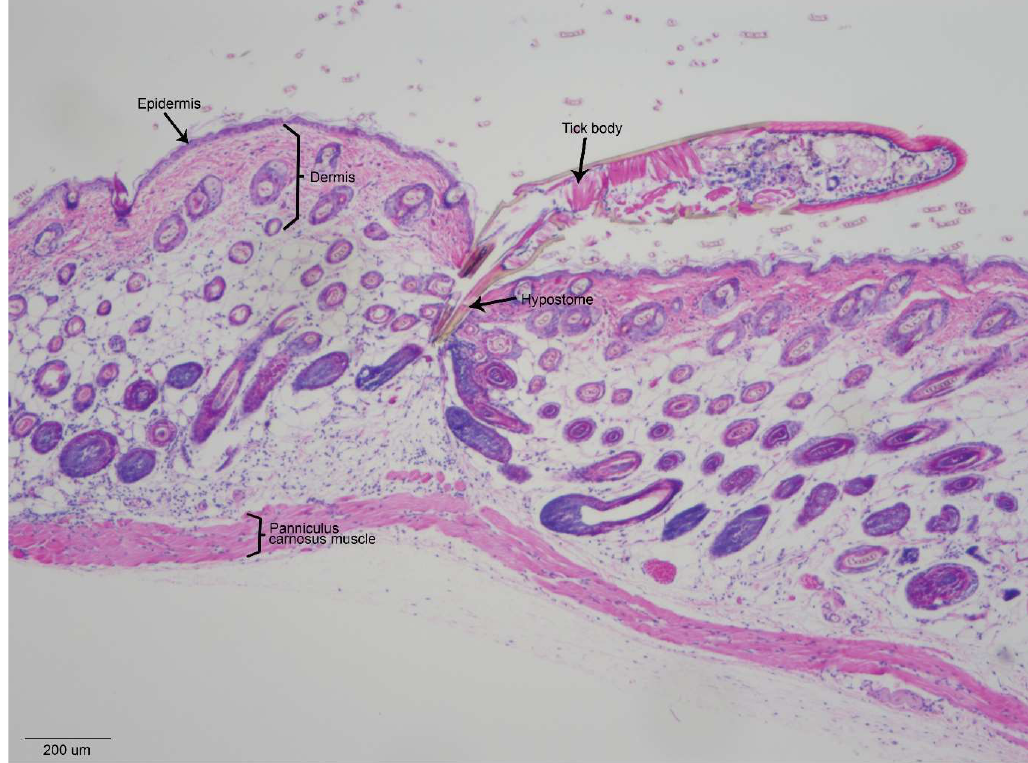
Figure 3. Histopathology of Ixodes scapularis nymphal feeding site at 3 h post infestation. The skin biopsy was harvested from the upper back of a mouse. The biopsy was fixed in 10% neutral-buffered formalin followed by decalcification prior to paraffin embedding. Five micron sections were stained with hematoxylin and eosin. Scale bar represents 200 µm.